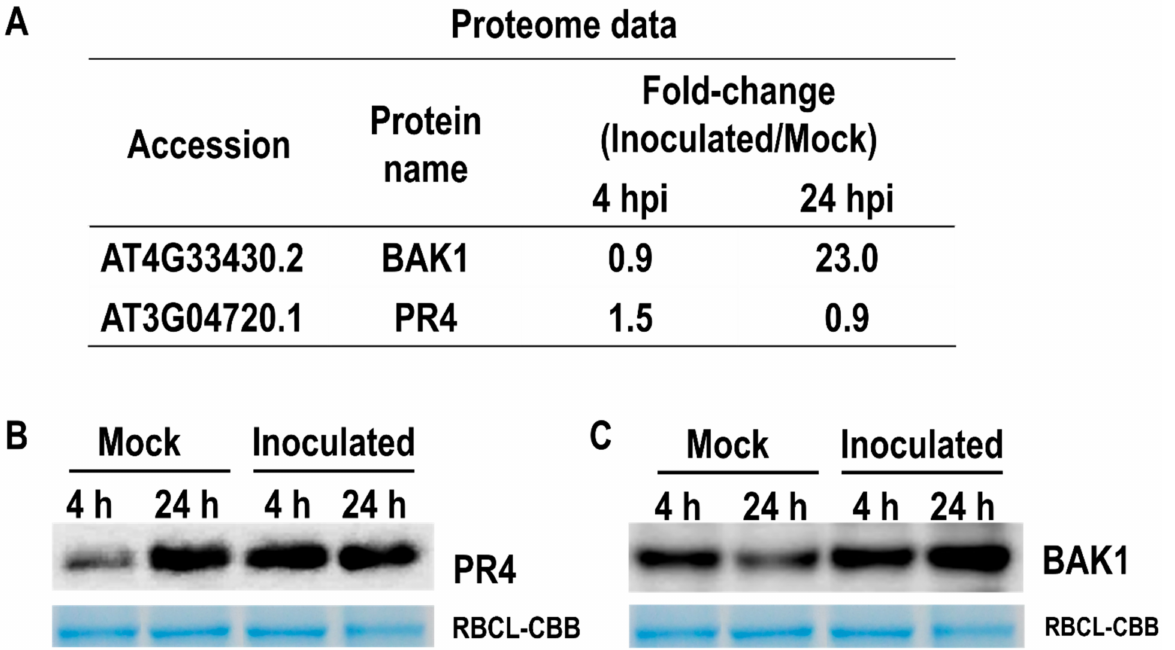
Figure 5. Protein accumulation was confirmed by immunoblotting analysis. ( A ) Proteome data of two accumulated proteins were based on LC-MS/MS analysis. ( B , C ) show that the accumulation of PR4 and BAK1 proteins can be confirmed by Western blotting analysis,